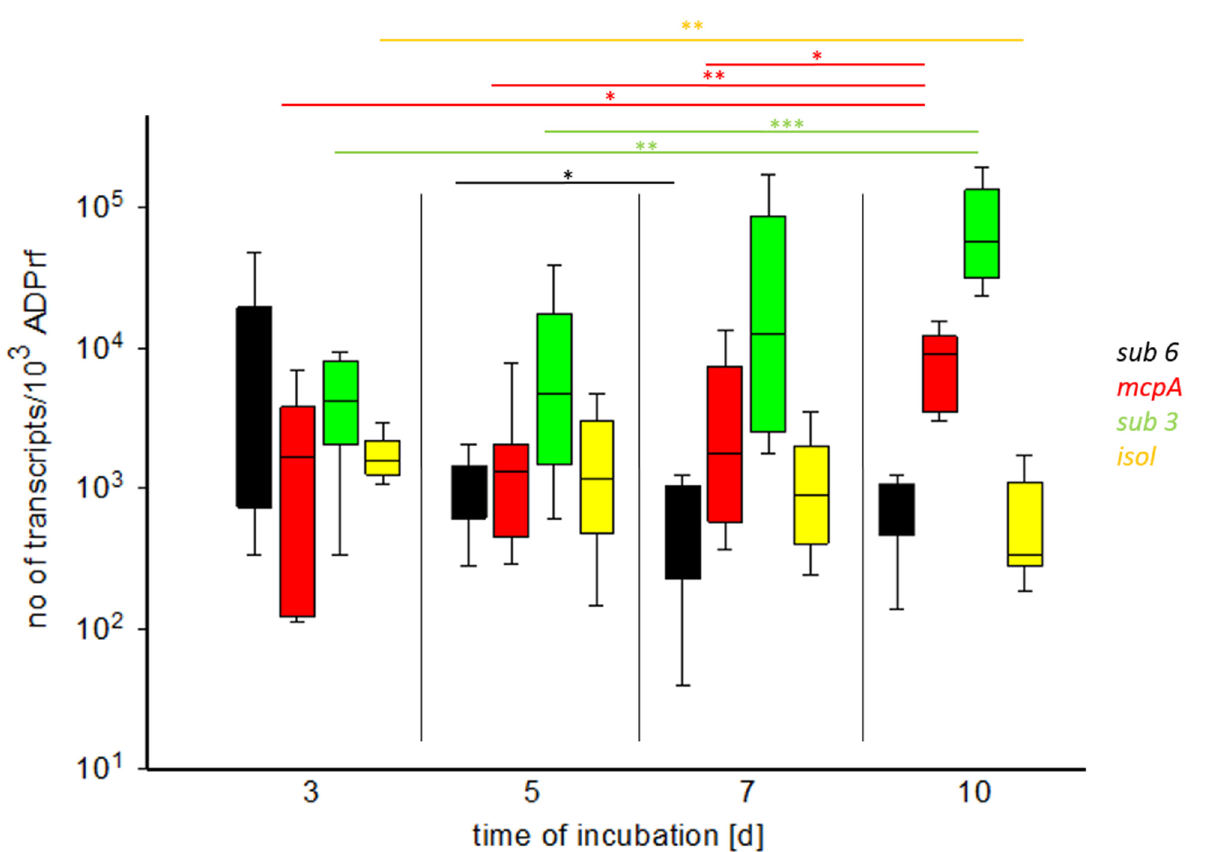
Figure 3. Expression rates of the virulence factor transcripts sub 3 (green), sub 6 (black), mcpA (red) and isol (yellow) of T. benhamiae isolates in GPSE culture from d 3 to d 10 (normalized to 10 3 ADPrf - transcripts). A significant increase of sub 3 - and mcpA -transcripts toward the end of culture was noticed. On the contrary, the number of isol -transcripts decreased significantly. Furthermore, sub 3